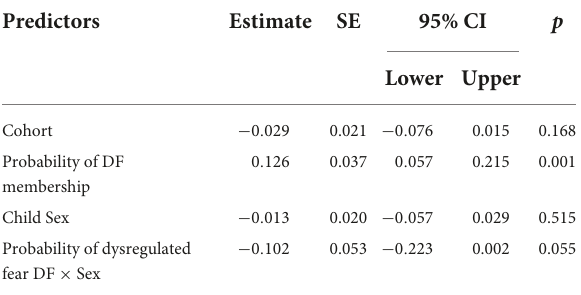
TABLE 7 Summary of multiple regression of membership in dysregulated fear (DF) profile, child sex, and their interactions on behavioral coding of reticence during a peer play task.